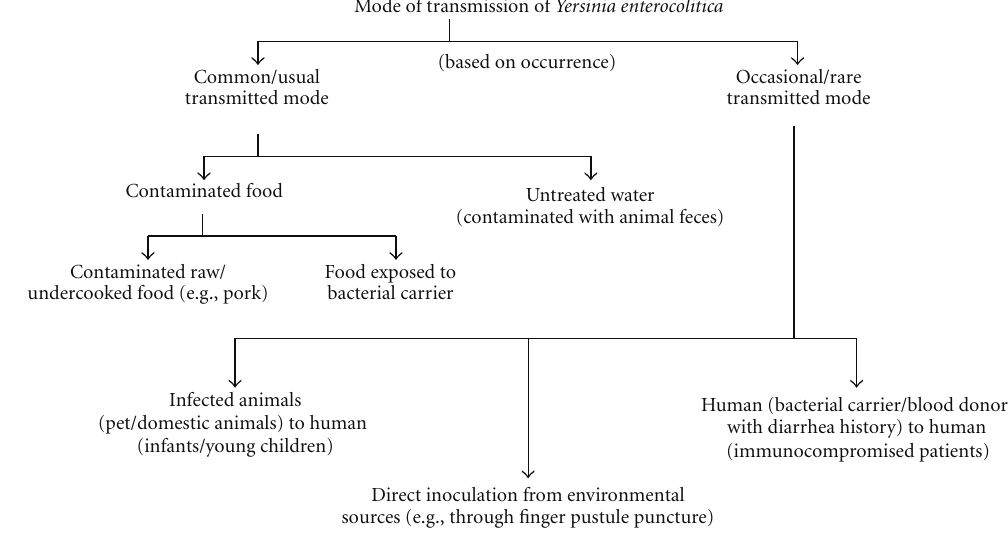
Figure 1: Mode of transmission of Y.